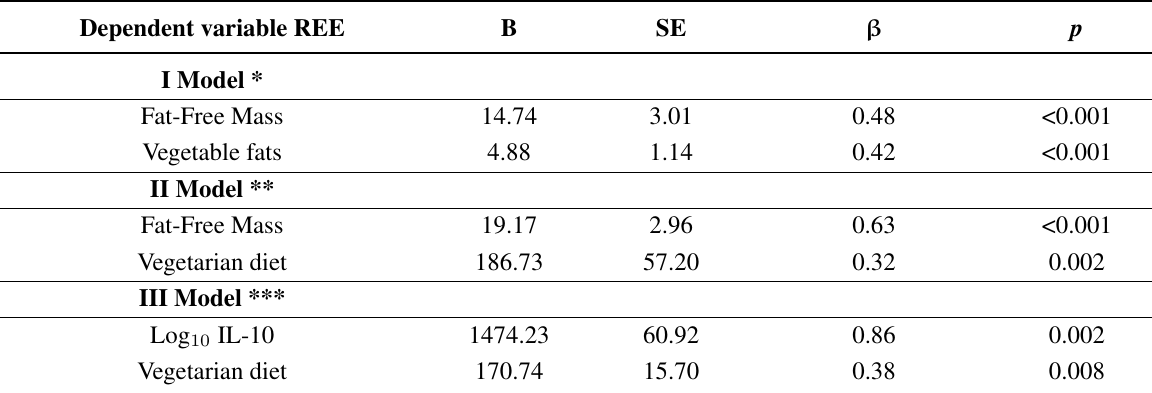
Table 4. Multivariate analysis, factors associated with resting energy expenditure (REE) as dependent